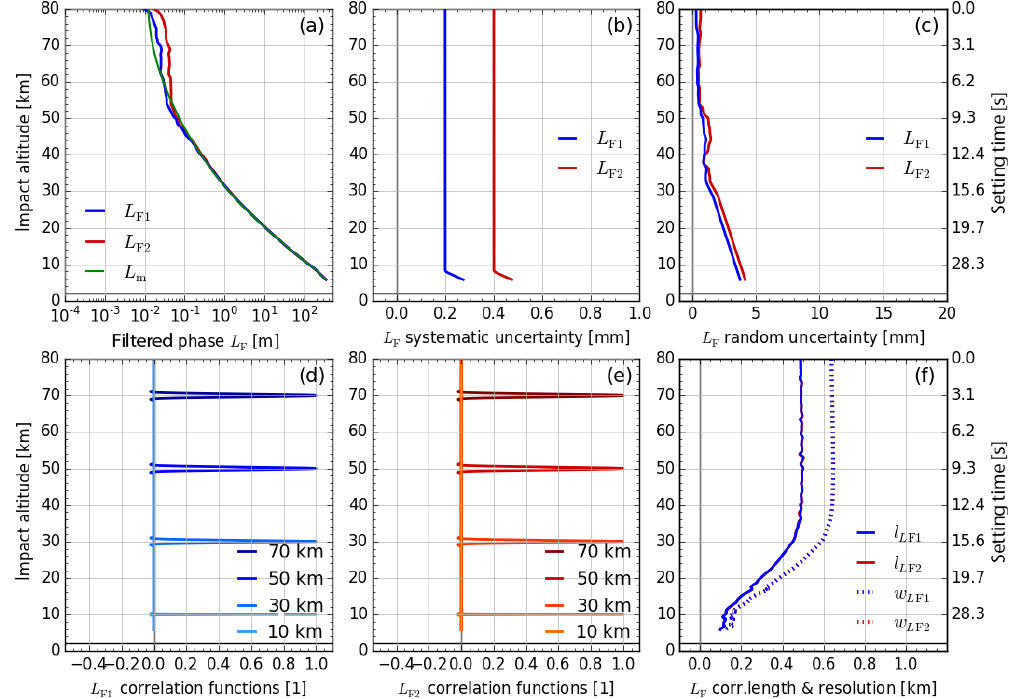
Figure 4. Results for filtered excess phase profiles L F (with model profile L m for comparison) in panel (a) , estimated systematic uncertainty profiles u s in panel (b) , estimated random uncertainty profiles u r in panel (c) , representative correlation functions R L F ,i (at 10, 30, 50, L F L F and 70km) in panels (d) and (e) , and correlation length l L F (solid) and resolution profiles w L F (dotted) in panel (f) . All profiles are shown for both GPS carrier frequencies: f T1 (blue) and f T2